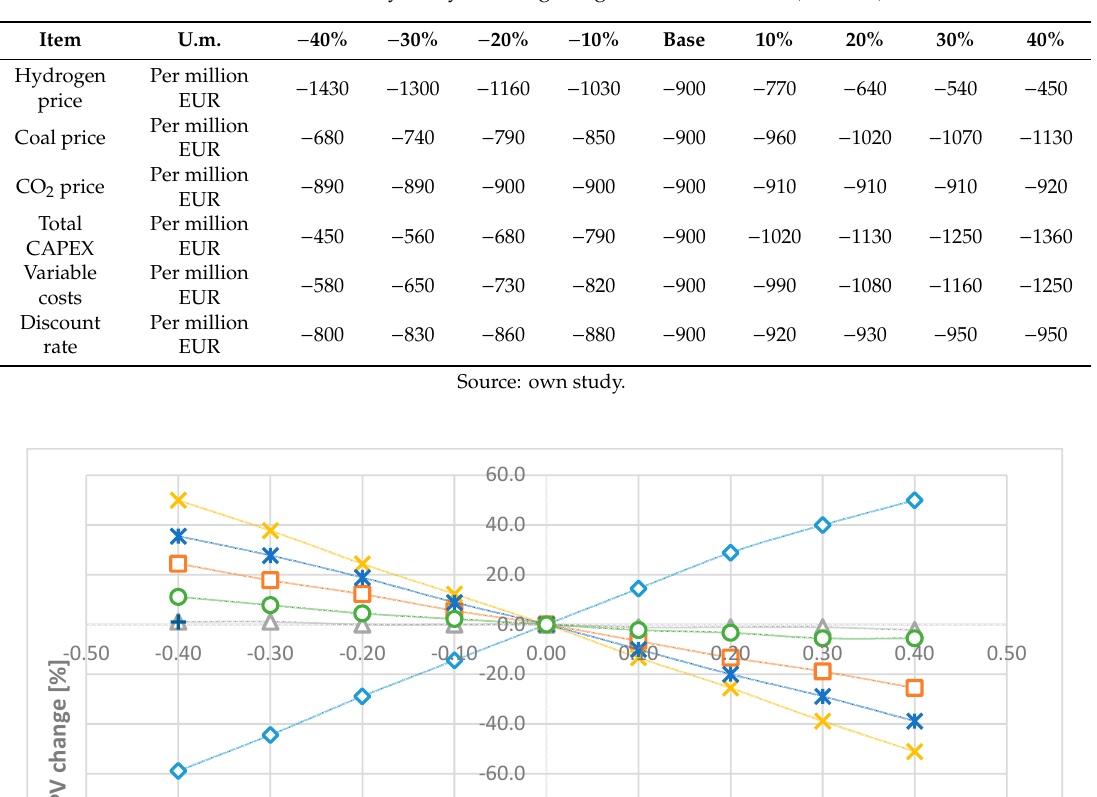
Figure 5. Sensitivity analysis for lignite gasification w/o CCS unit (L_H2_0). Source: own study.